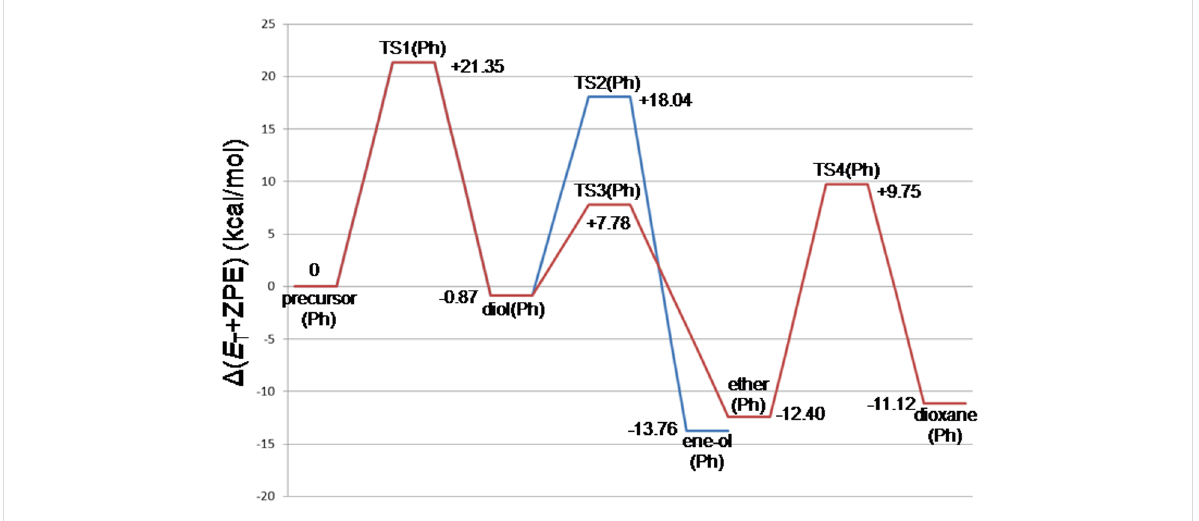
Figure 4: Energy changes (in kcal/mol) of the styrene Prins reaction calculated by B3LYP/6-311+G(d,p) SCRF = (PCM, solvent = water)// B3LYP/6- 31G(d) ZPE. The corresponding geometries are shown in Figure 3 and Figure S3.